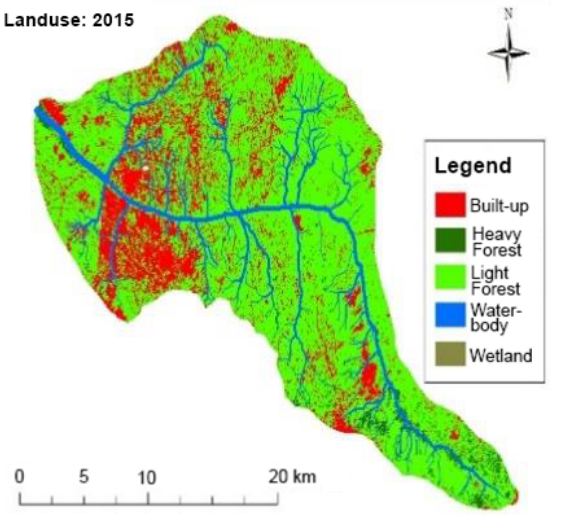
Figure 4. Landuse/landcover pattern in